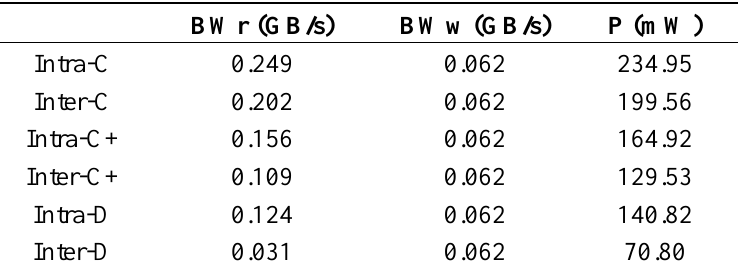
Table 9. Power analysis of 1080 p for